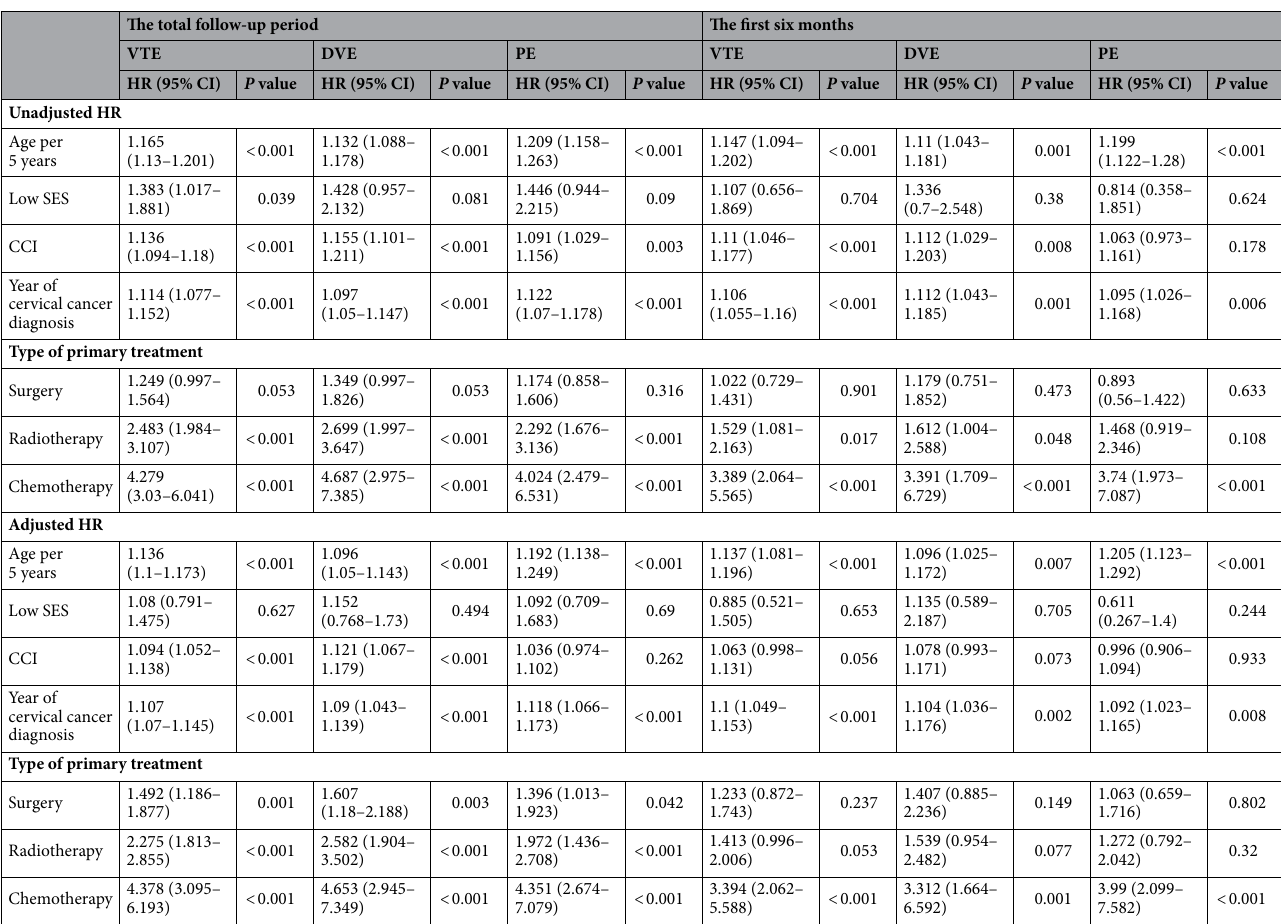
Table 3. Association of risk factors with VTE occurrence in patients with cervical cancer (HIRA claims data of 2009–2018). CI confidence interval, HR hazard